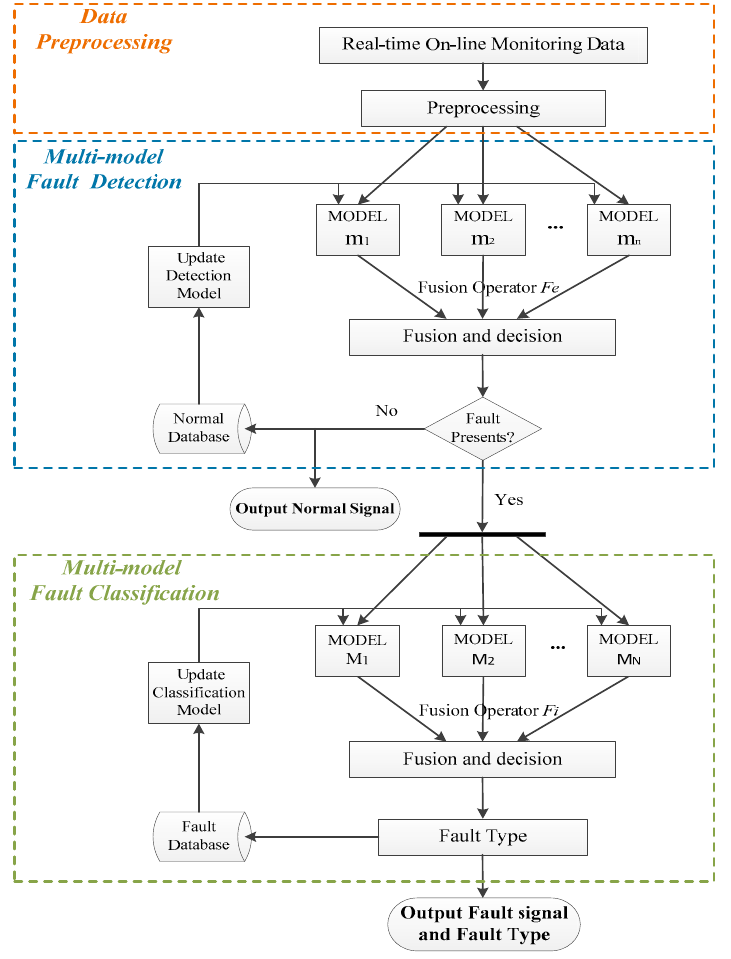
Figure 1. Flowchart of the diagnosis method.